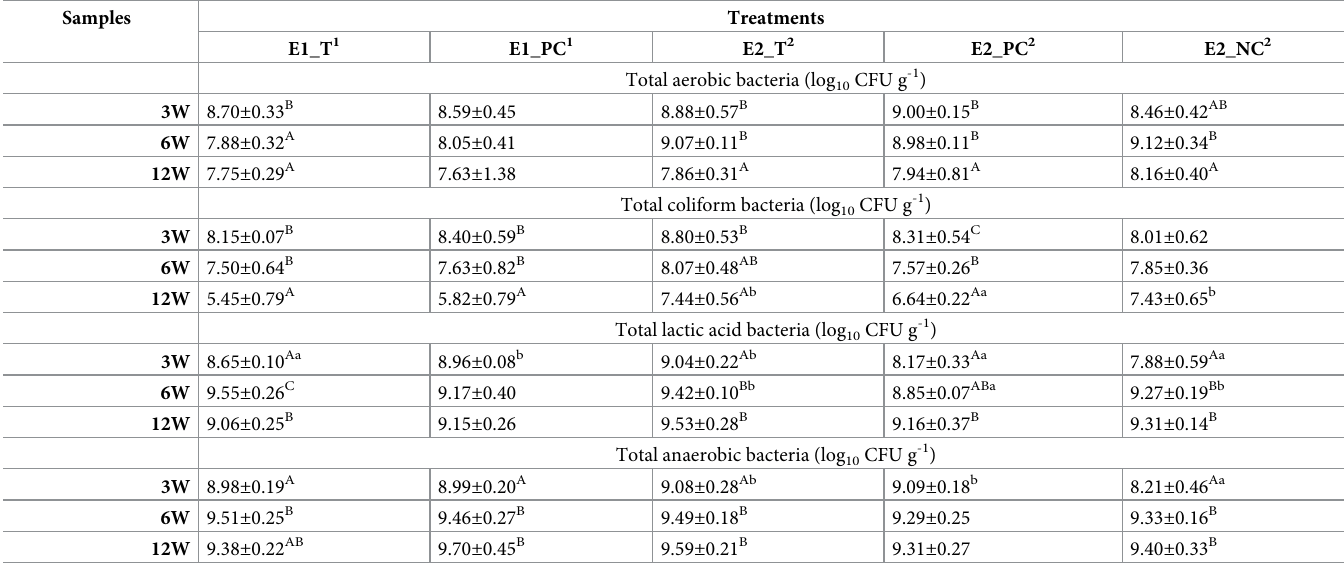
Table 2. Fecal microbiota composition of piglets at different ages and diets. Samples